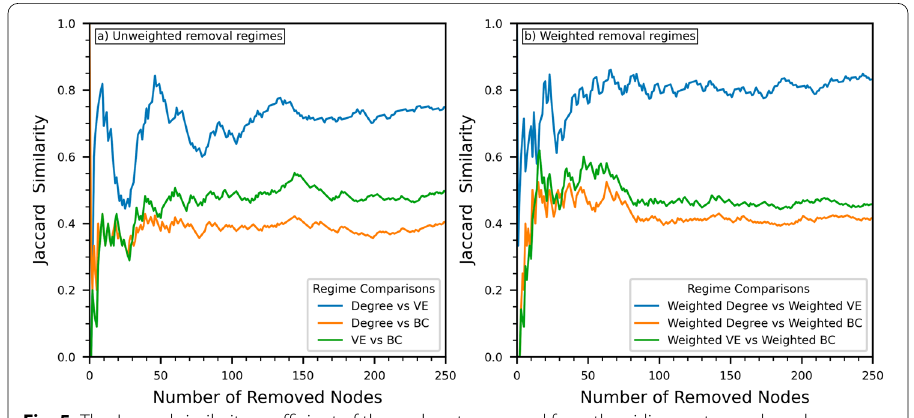
Fig. 5 The Jaccard similarity coefficient of the node sets removed from the airline route graph under targeted node removal. a Compares the unweighted forms of degree, vertex entropy and betweenness centrality. b Compares the weighted forms of degree, vertex entropy and betweenness